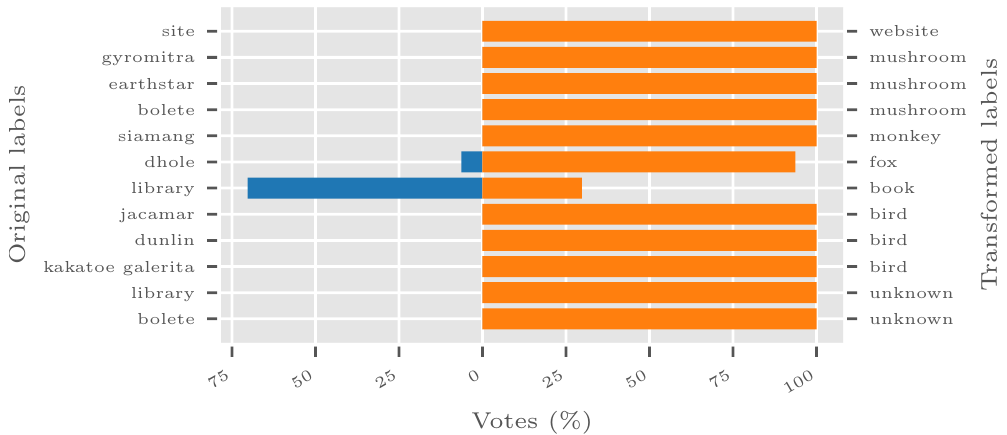
Figure 10. Results of the final verification of the ILSVRC2012 experiment. Even if the disjointed sample of the population is tested, they still prefer CRT-transformed categorization by a large margin. The blue bars denote the percentage of votes for the original category, and orange bars denote votes for the transformed category. Note that most of the previous categories did not get even a single vote.